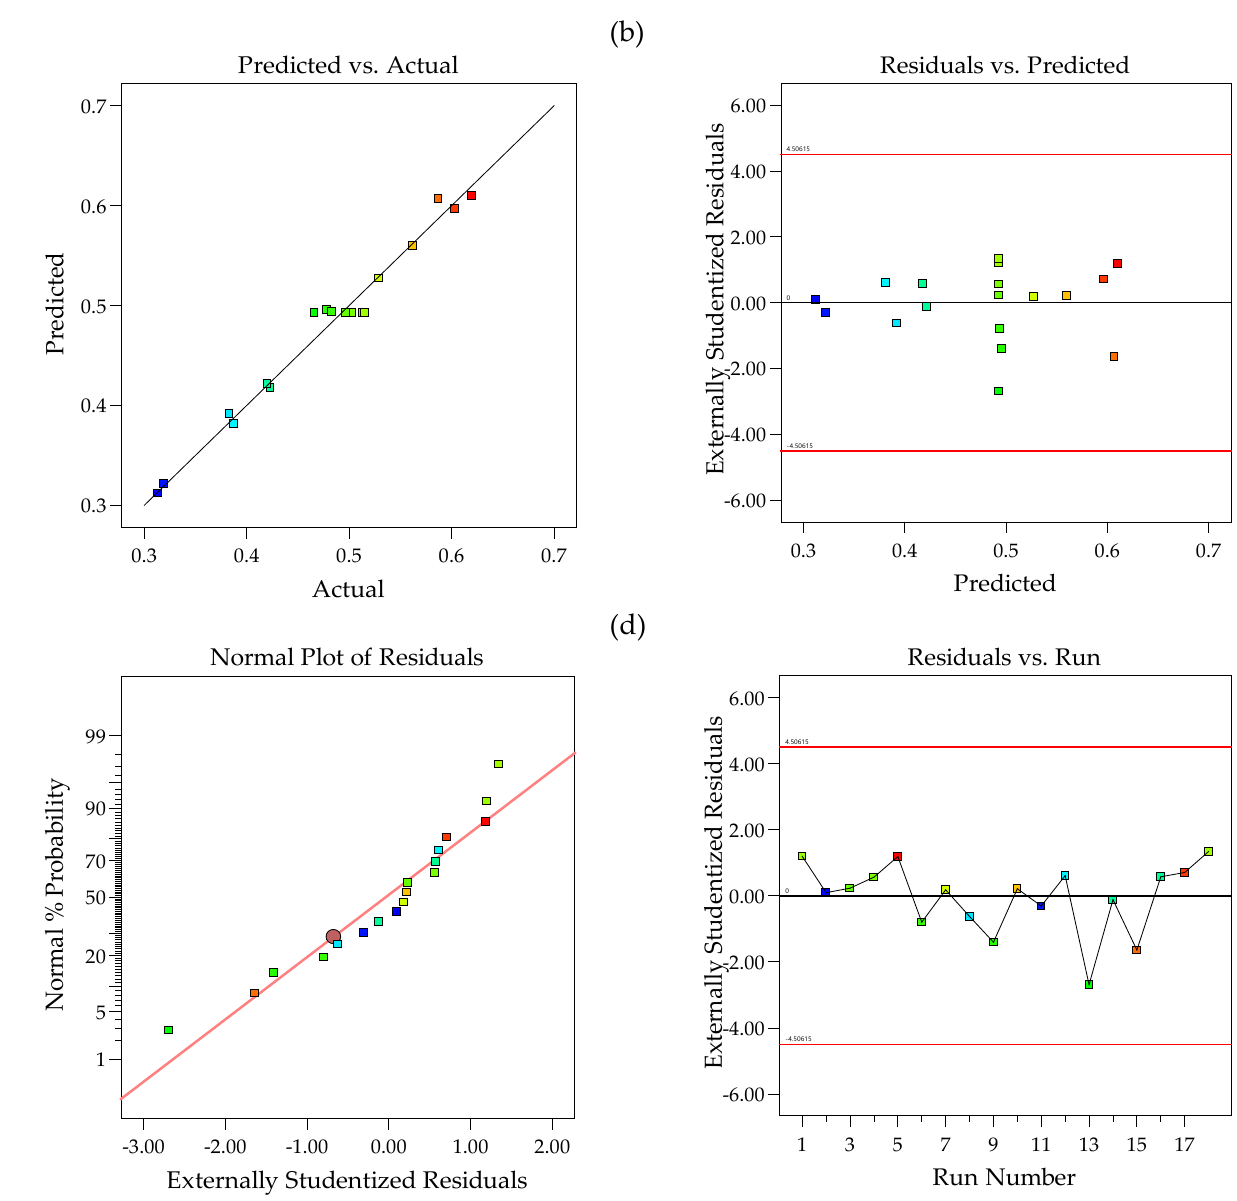
Figure 5. The CCD predicted value of CO 2 removal efficiency vs. ( a ) actual absorption and ( b ) externally studentized residuals, and externally studentized residuals vs. ( c ) normal probability and ( d ) experiment run number.